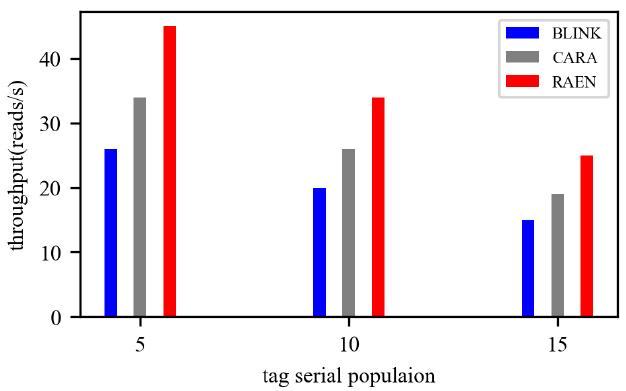
Figure 13. Overall throughput comparison for